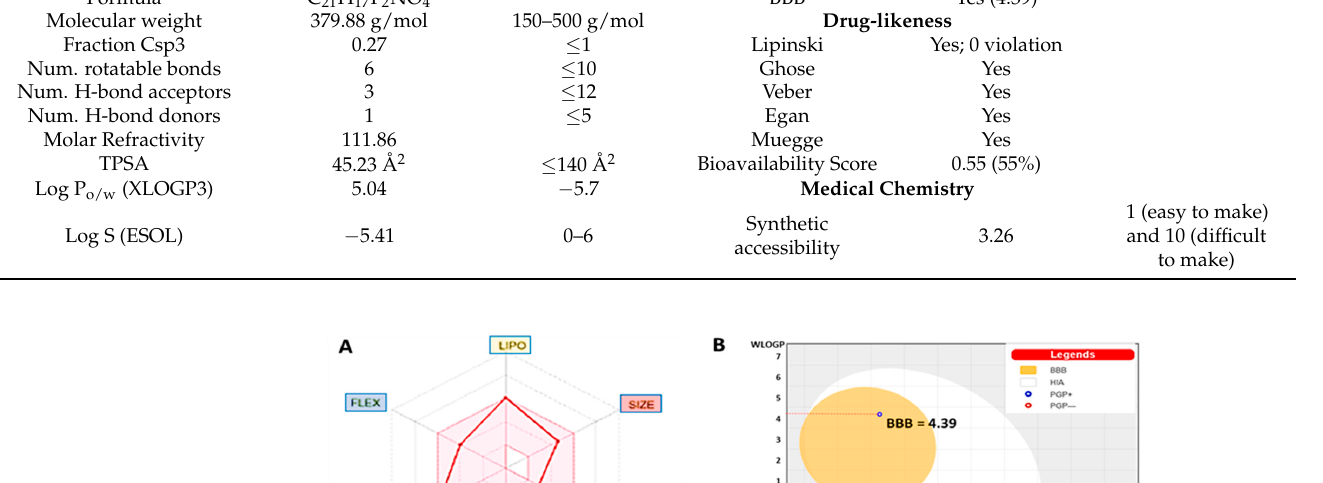
Figure 9. Drug sensitivity of the c-Met/GSK3 β /MYC/CCND1 oncogenes from the GSCA. Correlations among genomics of drug sensitivity in cancer (GDSC) of FDA-approved drugs. Positive Spearman correlation coefficients (orange circles) indicate that increased gene expression Table 2. Physiochemical properties, pharmacokinetics, drug-likeness, and medical chemistry. levels were resistant to the drug, compared to negative correlations shown in blue, which indicate sensitivity to the drug. Physicochemical Properties Based on Bioavailability Radar of NSC765600 3.8. Evaluation of Drug Likeness, ADME Properties, and Friendliness of NSC772864